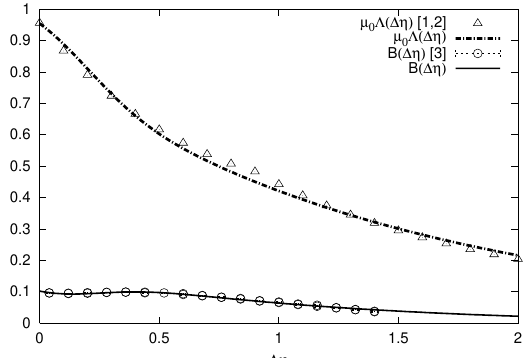
Figure 1. The results of simultaneous fitting (lines) by formulas (11) and (19) of the string two- particle correlation function µ 0 Λ ( ∆ η ) (triangles), extracted in [12] from the ALICE data [11] on the FB correlations (see Section 3), and the balance function B ( ∆ η ) (circles) measured by ALICE [13] in pp collisions at 7 TeV Table 1. The value of the parameters in formulas (20) and (21) for the charge-wise correlation functions of a string Λ opp ( ∆ η ) and Λ same ( ∆ η ) obtained by the fit procedure, which is presented in Fig. 1 a opp same HBT µ 0 Λ a 1.16 0.5 0.25 0 η a 1.34 1.87